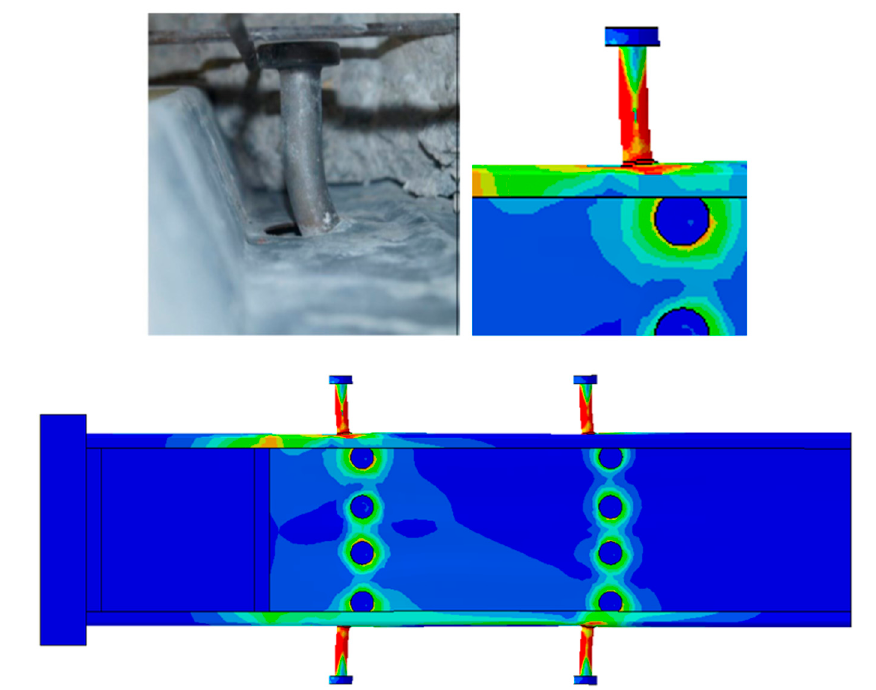
Figure 9. Failure mode of the HSSC test specimen compared to the FE model.